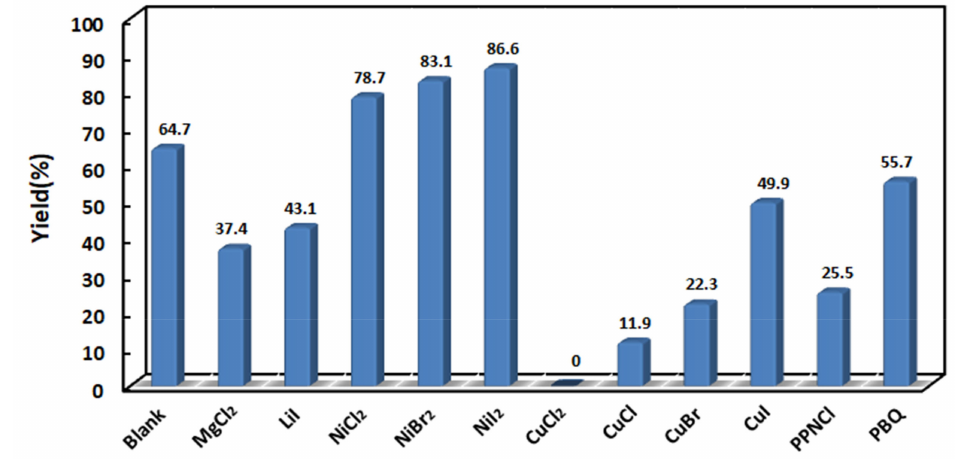
Figure 4. Yield vs. different metal salts of Eug-HDI